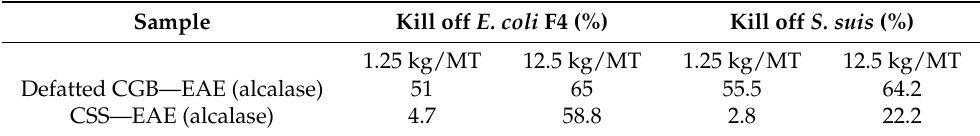
Table 5. Analyzed antimicrobial activity of